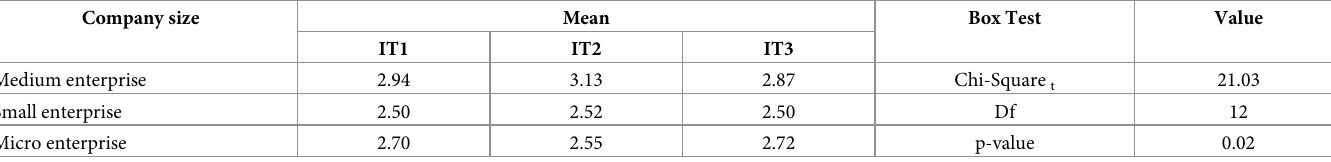
Table 4. Company classification, institutional trust and Box test.